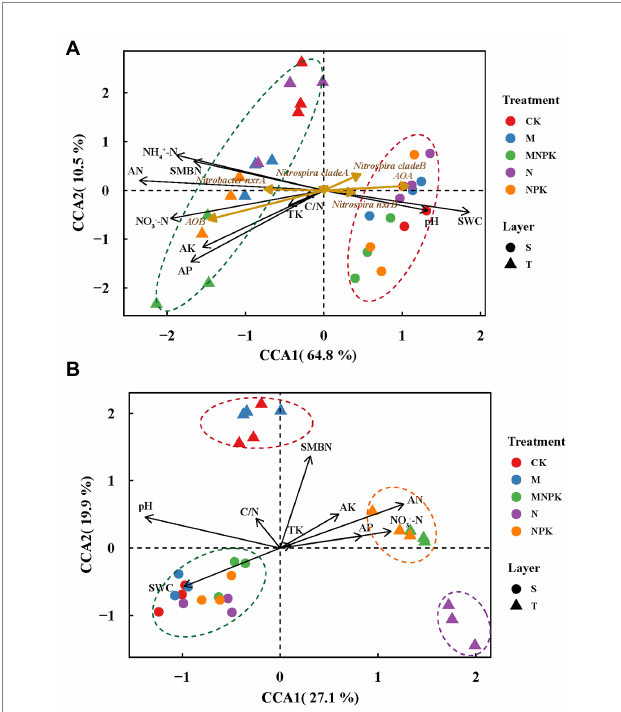
FIGURE 3 Canonical correspondence analysis (CCA) plot based on the gene abundances of all nitrifying populations (A) and comammox Nitrospira OTU compositions (B). Circles, subsoil samples, S; triangles, topsoil samples, T; black arrows, soil physiochemical properties; dark goldenrod arrows, nitrifiers. Red, blue, green, purple, and orange colors represent CK, M, MNPK, N and NPK treatments, respectively. Abbreviations: SWC, soil water content; TK, total K; AN, available N; AP, available P; AK, available K; NH 4+ -N, ammonium N; NO 3 − -N, nitrate N; SMBN, soil microbial biomass N; C/N, the ratio of total C to total